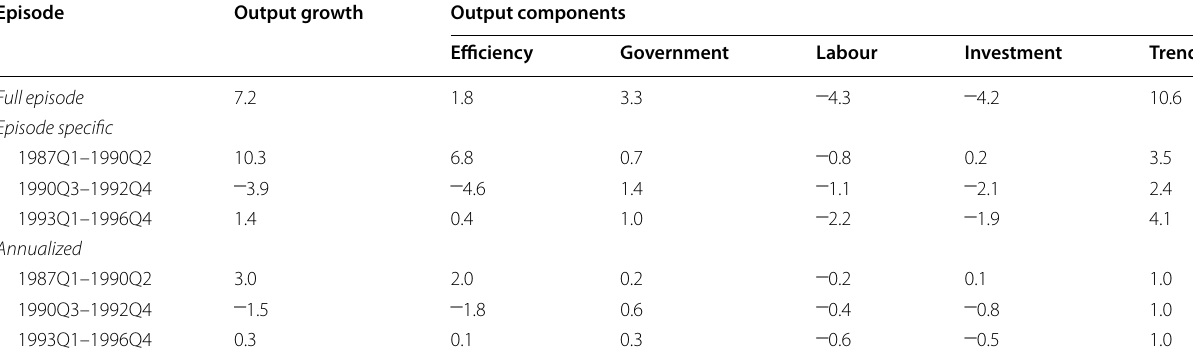
Numbers in per cent. Output growth measured in real per capita terms